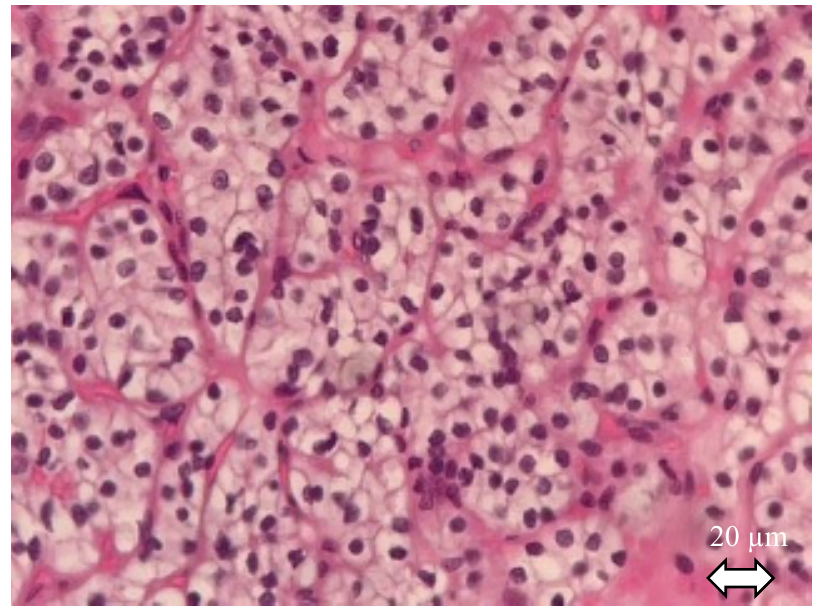
Figure 1. Clear cell renal cell carcinoma. Hematoxylin and eosin staining. The tumor shows solid alveolar growth pattern with regular network of small thin-walled blood vessels. Neoplastic cells have clear cytoplasm filled with lipids and surrounded by distinct cell membranes.